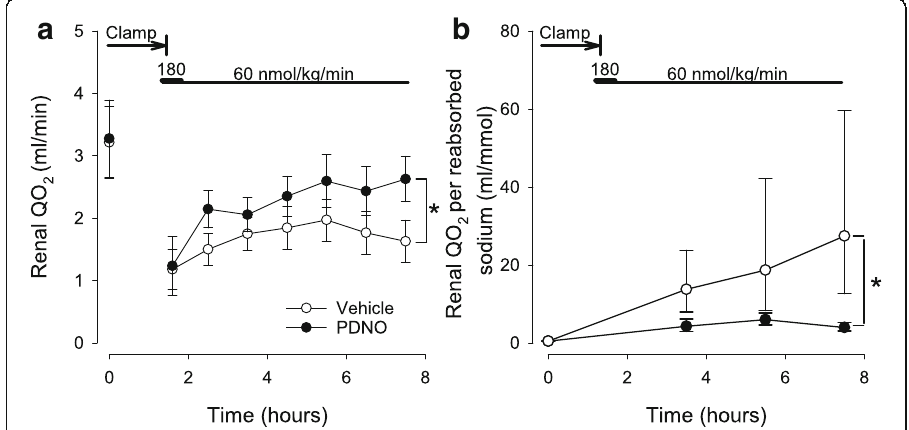
Fig. 4 Renal oxygen consumption (QO 2 , a ) and renal QO 2 per reabsorbed sodium ( b ) in 16 sheep subjected to renal ischemia and reperfusion. Renal ischemia was caused by clamping of the renal artery for 90 min. Fifteen minutes prior to the release of the clamp intravenous treatment with either 1,2-propanediol nitric oxide (PDNO, n =8) or vehicle (propanediol + inorganic nitrite, n =8) was commenced. The treatment continued for 6 h. Data are expressed as mean and SEM. Significant ( p <0.05) differences in response to PDNO compared to vehicle is indicated by an